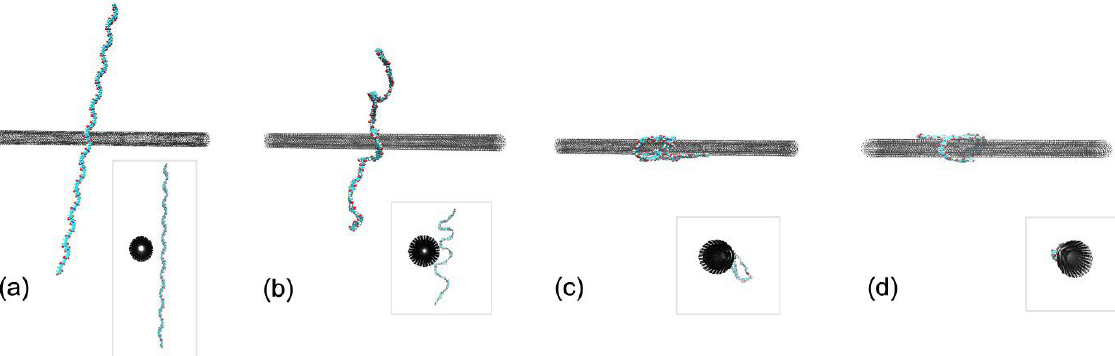
Figure 5: MD snapshots of a single PI chain interacting with a TWCNT at the following time steps (in ns): (a) 0.000, (b) 0.020, (c) 0.074, (d)